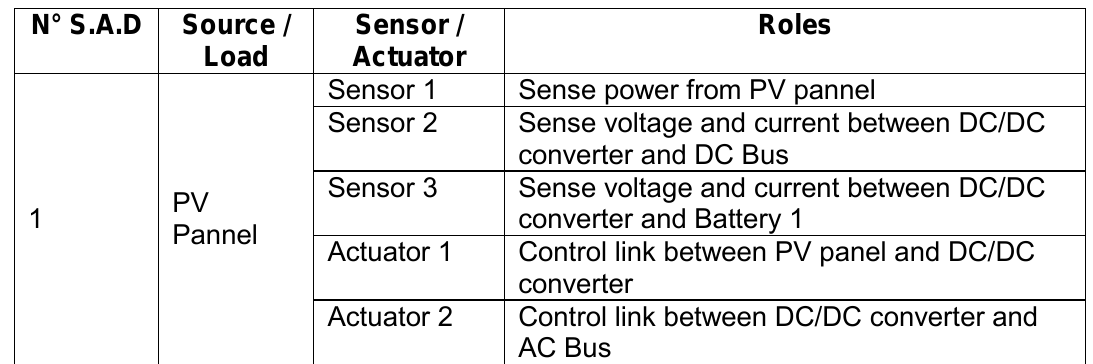
Table 1. S.A.D roles in the